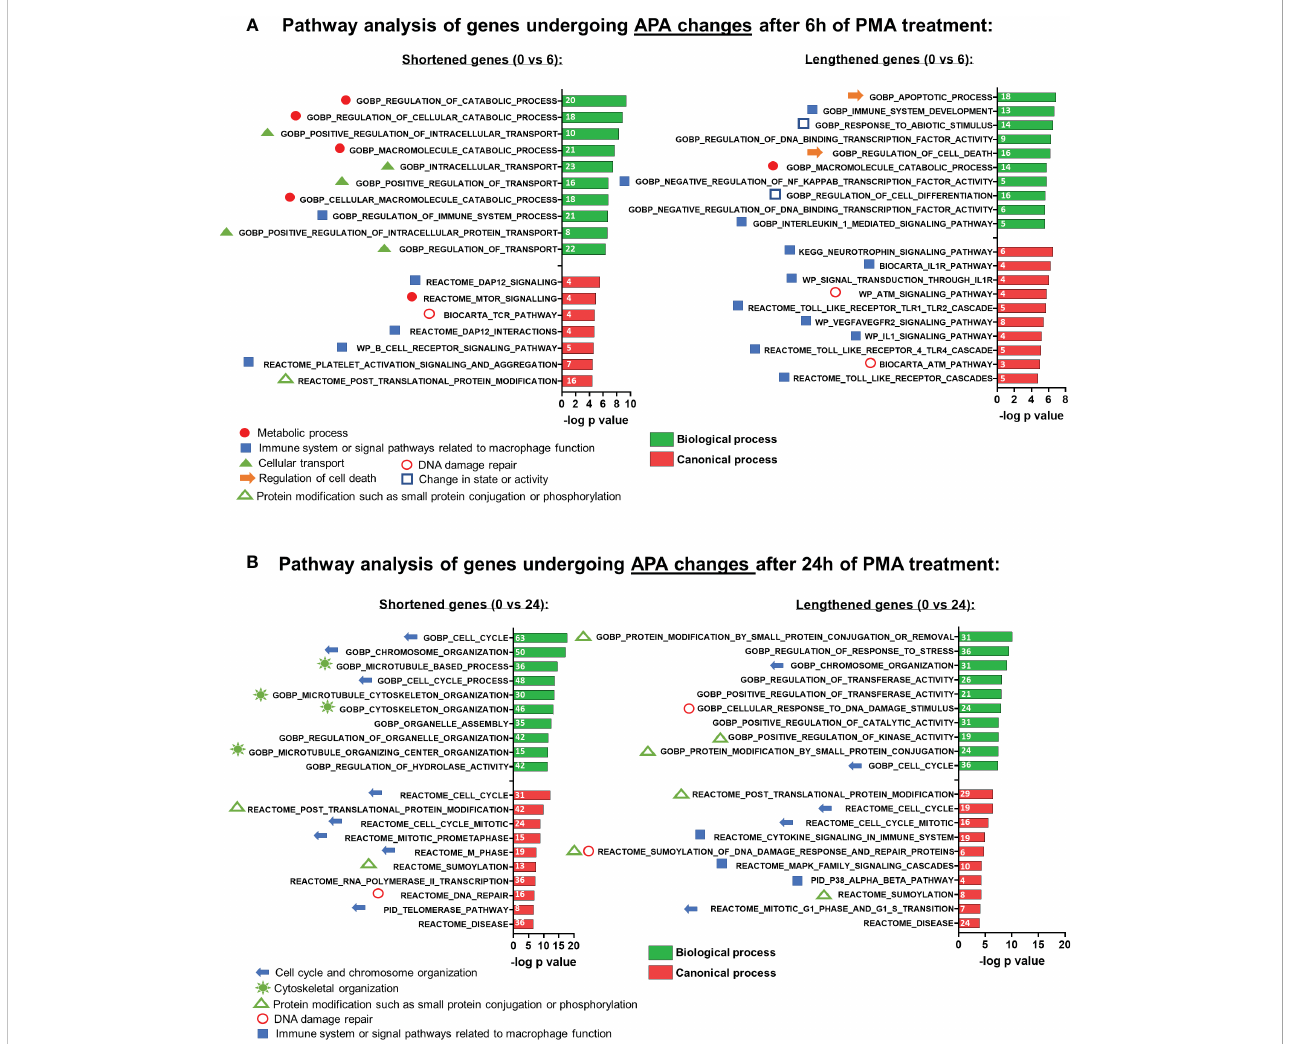
FIGURE 3 Gene set enrichment analysis (GSEA) of APA events in U937 cells after PMA treatment. Functional annotation clustering of mRNAs whose APA is regulated and after 6h (A) and 24h (B) of differentiation. The 10 most signi fi cant GO-process enriched gene groups for biological process (green) or canonical process (red) are ranked based on negative log 10 (P-values) for shortened (left panel) and lengthened (right panel) transcripts. Pathways classi fi ed according to speci fi c cellular processes are grouped together as indicated by the individual symbols at the bottom of the